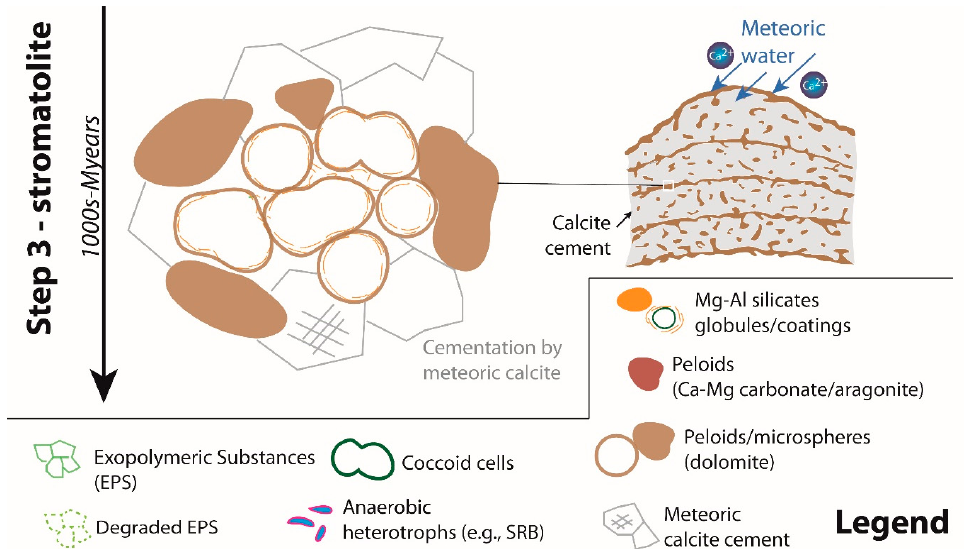
Figure 20. Geomicrobiological scenario explaining the formation of typical TCC microbialites at two scales: (i) the microbial mat (at this scale, the model explains the formation of the laminated peloidal microfabric (Figure 4)); and (ii) the microbial community (at this scale, the model describes the formation of peloids and microspheres and the evolution of mineral phases through diagenesis (paragenesis)). The scenario implies classical cation sources (surface water, silicate alteration) plus hypogenic sulfate ‐ rich brines derived from Messinian gypsum dissolution. The formation of microbialites is divided into three steps. Step 1: Depositional microbial processes. At this stage, a layered microbial mat develops. Microbial layering depends on light and chemical gradients. The surface/green layer (i.e., the first millimeters) of the mat is constituted of oxygenic phototrophs (OP), in that case cyanobacteria and diatoms, producing abundant EPS that bind calcium. The photosynthetic activity increases the pH (>9), leading to the dissolution of diatoms and to the nucleation of Mg ‐ Al silicates on the sheath of coccoid cyanobacteria, but also as globules within EPS. Aerobic respirers (AR) quickly consume oxygen, leading to the formation of an anoxic zone below the green layer. The red layer is dominated by anoxygenic photosynthesizers (AOP), potentially purple sulfur bacteria. Anaerobic respirers (AnR) are distributed in the whole mat, but are particularly active in the red and black layers. In the red layer, a synergy between purple sulfur bacteria and sulfate reducing bacteria leads to rapid sulfur cycling and increasing alkalinity. This synergy is fueled by sulfates coming from surface water, but also by seepage produced by the dissolution of the underlying gypsum. A metastable carbonate lamina develops at the interface between the green and red layer, where both pH and alkalinity are elevated. Metastable carbonate peloids nucleate in the red and black layers following the local degradation of EPS by AnR (including sulfate reducing bacteria) and subsequent release of calcium ions. The alternance between peloids and lamina results in the formation of a laminated peloidal microfabric. The process will then repeat over time through upward growth of the microbial mat. Step 2: Early diagenetic transformations. These transformations occur in the shallow subsurface (a few centimeters to meters deep) during the centuries to millennia following the initial mat development (Step 1). EPS are increasingly degraded through reduced, but still active AnR activity, inducing a lowering of porewater pH (<7). In such conditions, Mg ‐ Al silicates are partially to totally dissolved. A reaction between the released magnesium ions and degraded EPS leads to the replacement of metastable carbonates by dolomite. Step 3: Late diagenesis. Following the circulation of meteoric water in the rock, a calcite cement develops inside the stromatolite and fills part of the remaining porosity.